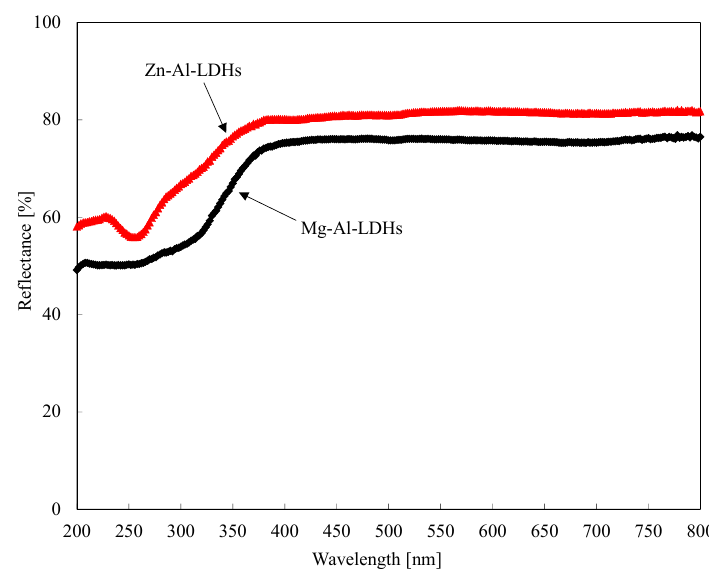
Figure 2. Reflectance of two types of LDHs.